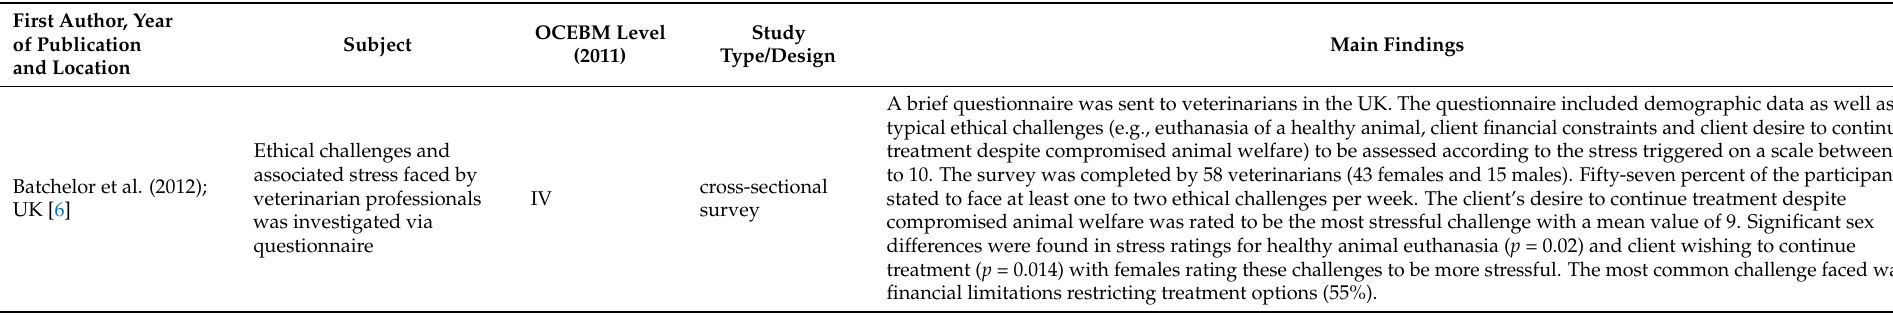
Table 2. Psychological